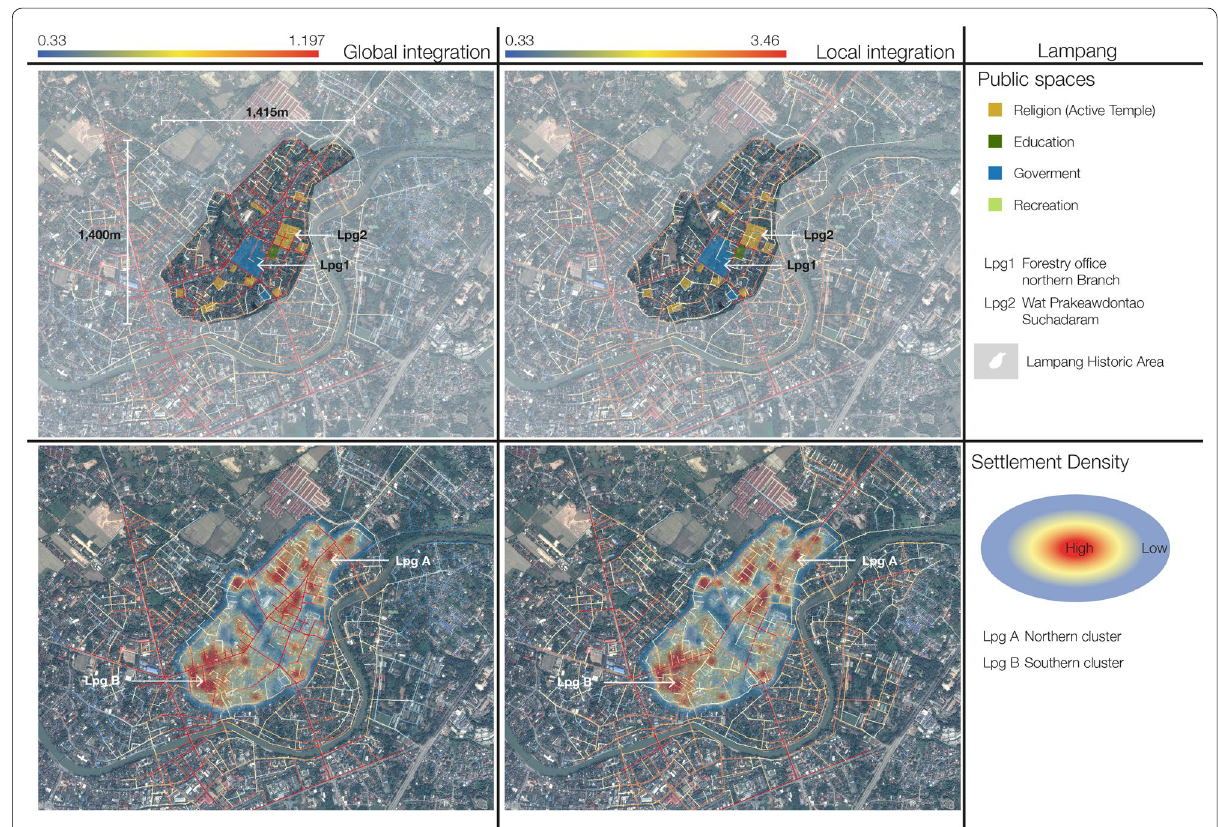
Fig. 6 Analysis of Lampang’s spatial